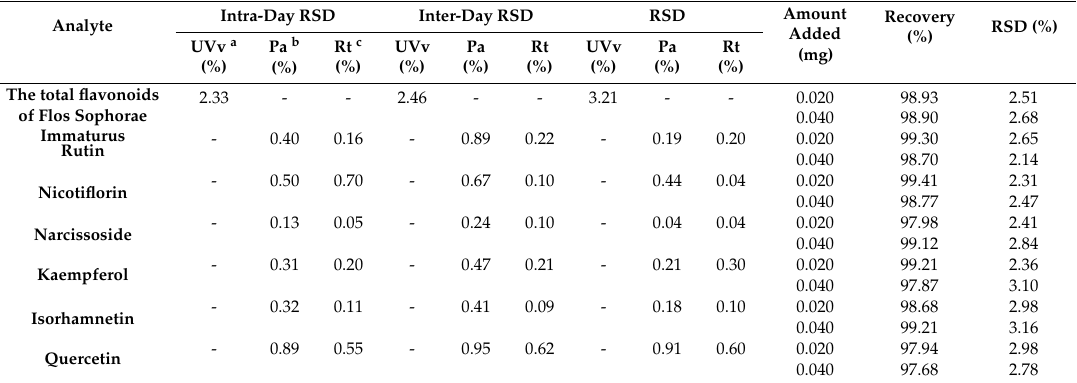
Table 4. Precision, repeatability, and recovery yields of the total flavonoids of Flos Sophorae Immaturus and six compounds ( n =